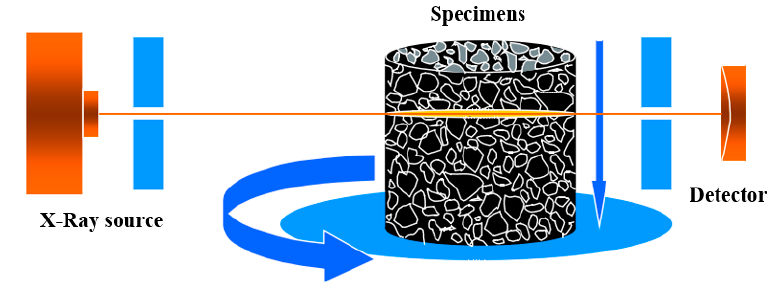
Figure 6. CT test principle.